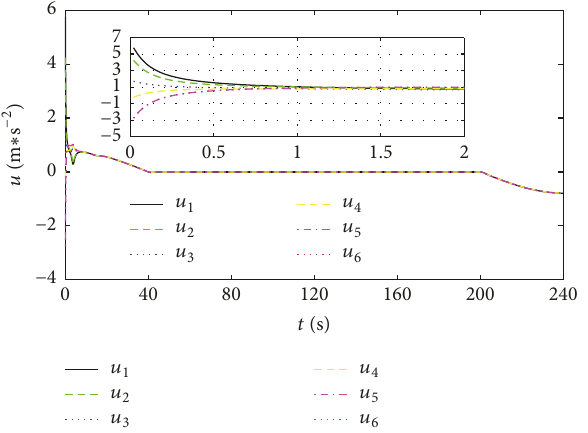
Figure 6: Positions of each vehicle and position gaps between